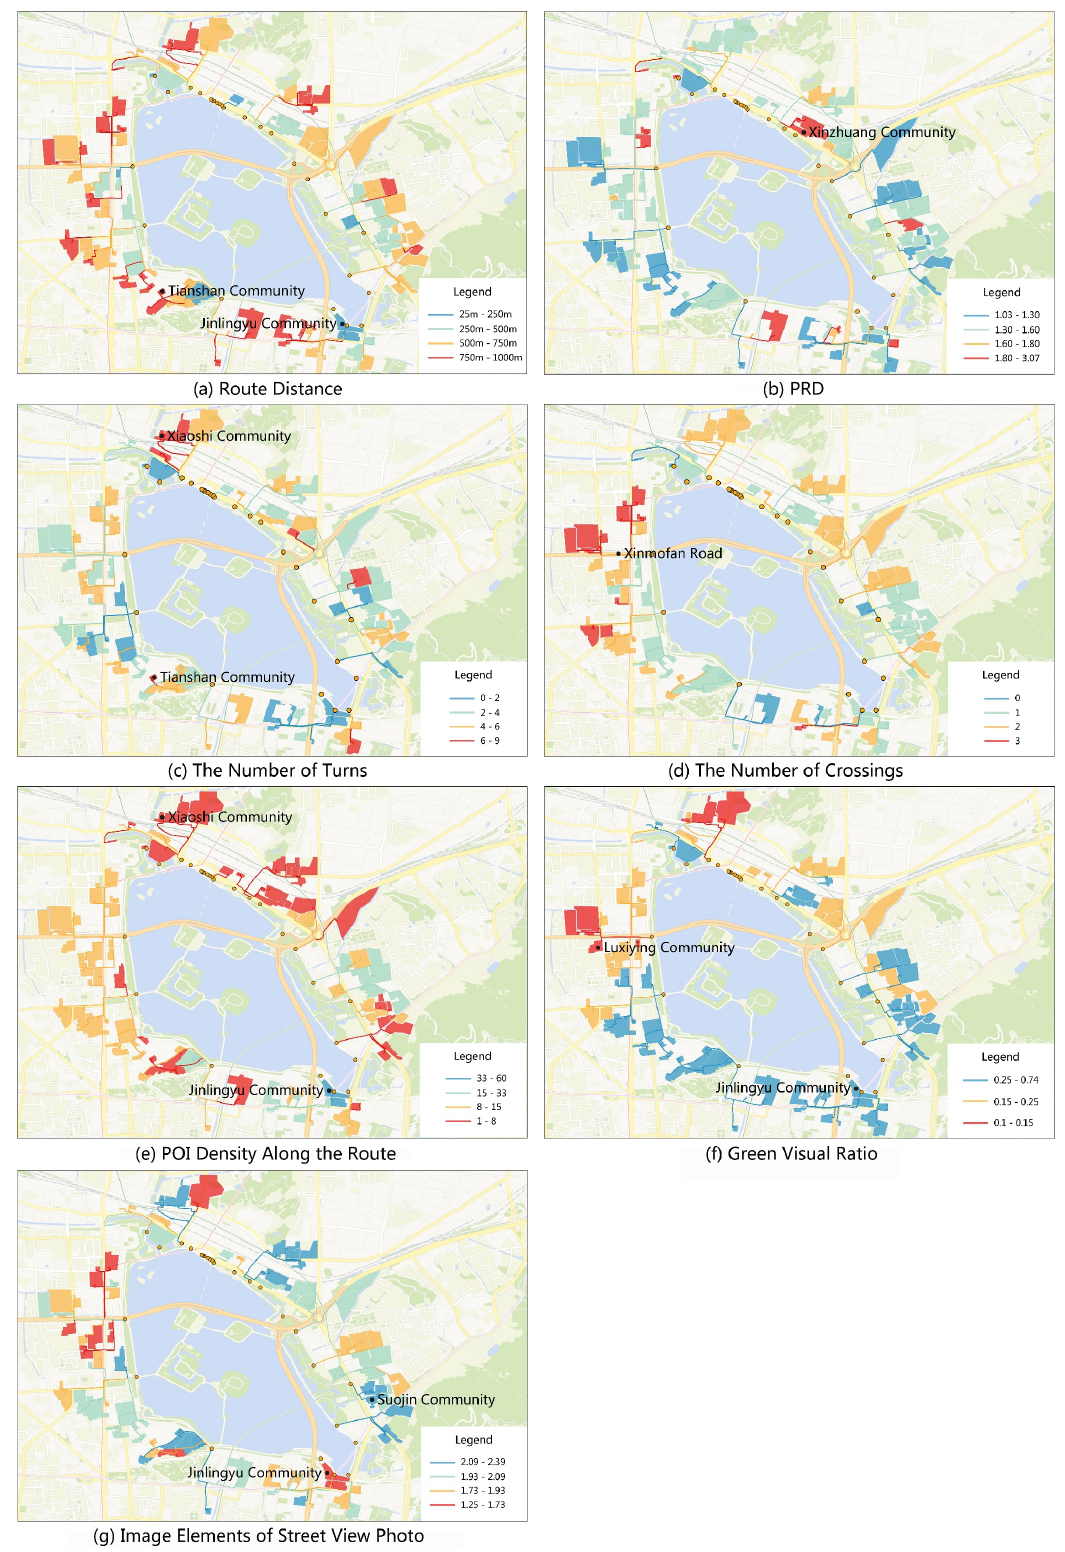
Figure 7. Pedestrian environment analysis of the routes from communities to the park: ( a ) route distance; ( b ) PRD; ( c ) the number of turns; ( d ) the number of crossings; ( e ) POI density along the route; ( f ) green visual ratio; and ( g ) image elements of street view photo (base map from Tianditu Map). Route distance: The average and median distances were 651 and 690 m, respectively. Eight routes were less than or equal to 250 m, 26 routes were less than or equal to 500 m, and 64 routes were